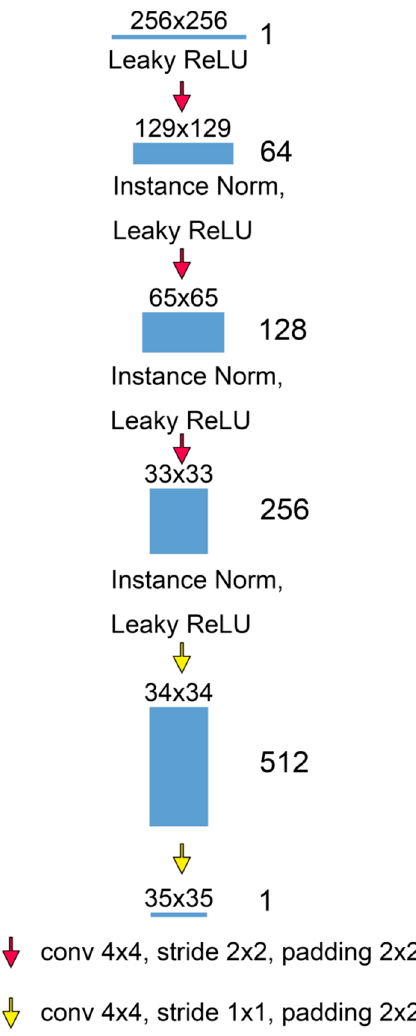
Figure 3. The architecture of the Markovian discriminator (also known as the patch GAN). It is a 5-layer FCN model for discriminating texture loss. It assumes that the independence between pixels is greater than a patch diameter and regards the image as a Markov random field. The Markovian discriminator runs in a convolutional way across the image, each time penalizing a part of the image at the patch scale. The ultimate output of the discriminator is the average of all responses of the patches.